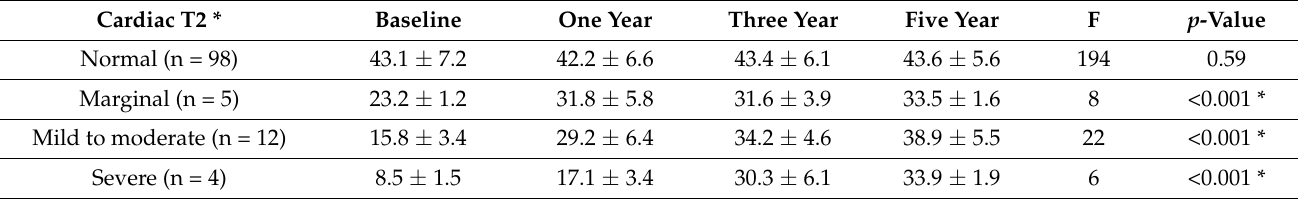
Table 2. Baseline and mean cardiac T2*at one year, three years, and five years in 4